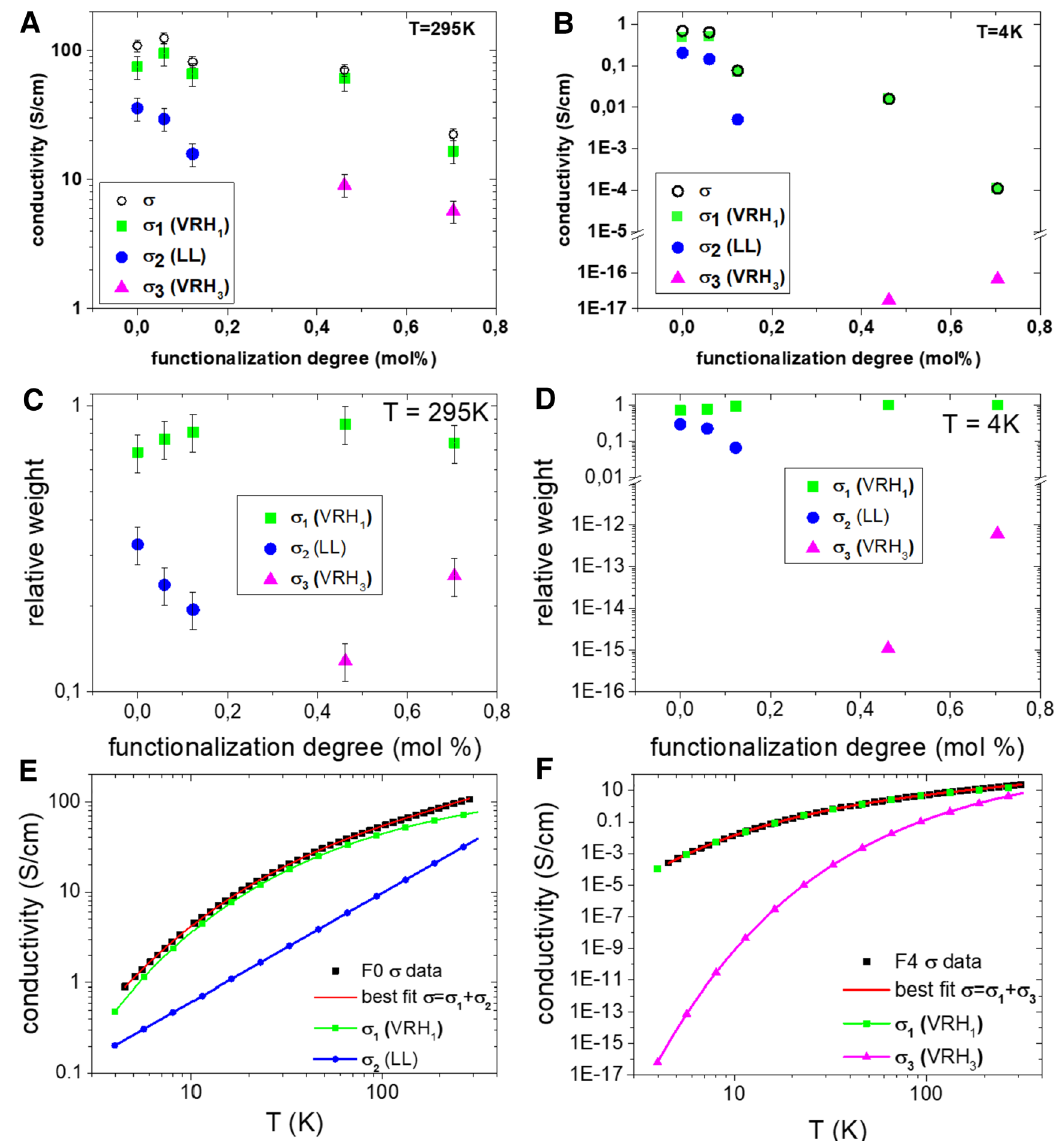
Fig. 4 Total ( σ ) and partial ( σ , σ , σ ) conductivities (in logarithmic 1 2 3 scale) as a function of the functionalization degree for T = 295 K ( A ) and T = 4 K ( B ); weight of the partial conductivities (in log scale) σ σ and σ in the total conductivity at 295 K ( C ) and at 4 K ( D ). Exam- 2 3